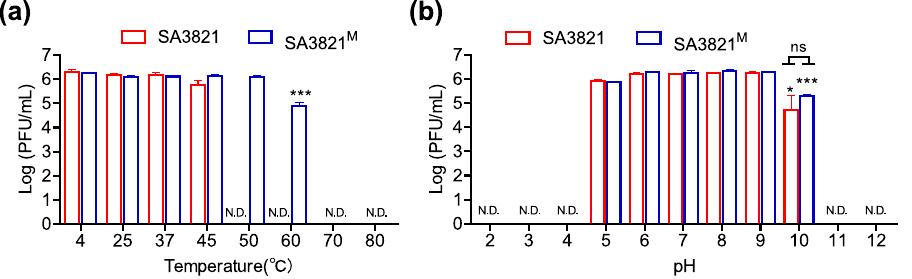
Figure 5. The stability of phages SA3821 and SA3821 M under various ( a ) thermal and ( b ) pH conditions. Each phage was exposed at the indicated temperature at a pH of 7.0 or pH at 25 °C for 1 h. Statistical differences were determined by comparing values ( a ) at 4 °C and ( b ) at pH 7. Results of three independent biological triplicates are shown as the mean and s.d. N.D. not detected, ns not significant; * P < 0.05; *** P < 0.001.